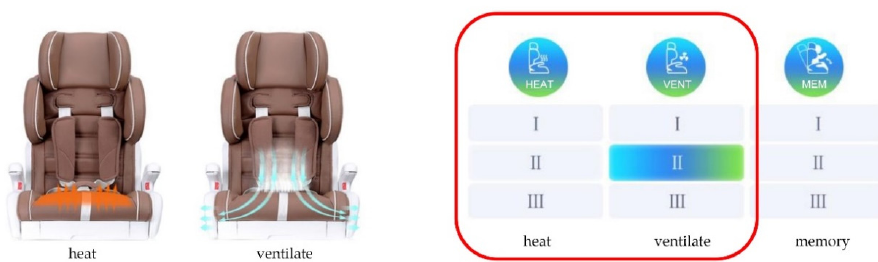
Figure 4. Heating and ventilation systems.